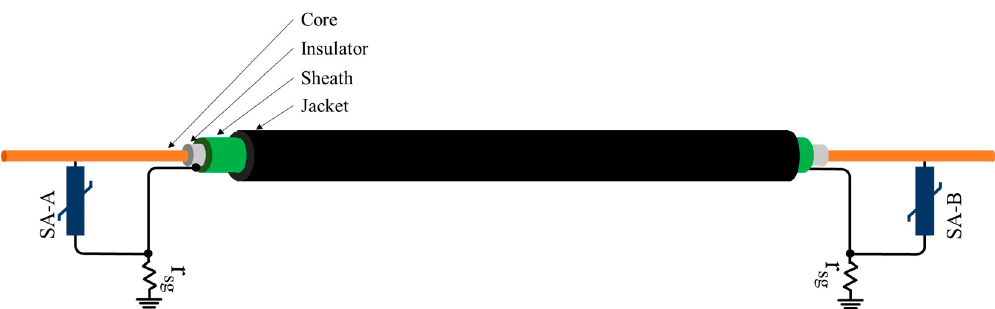
Figure 19. Location of surge arresters.